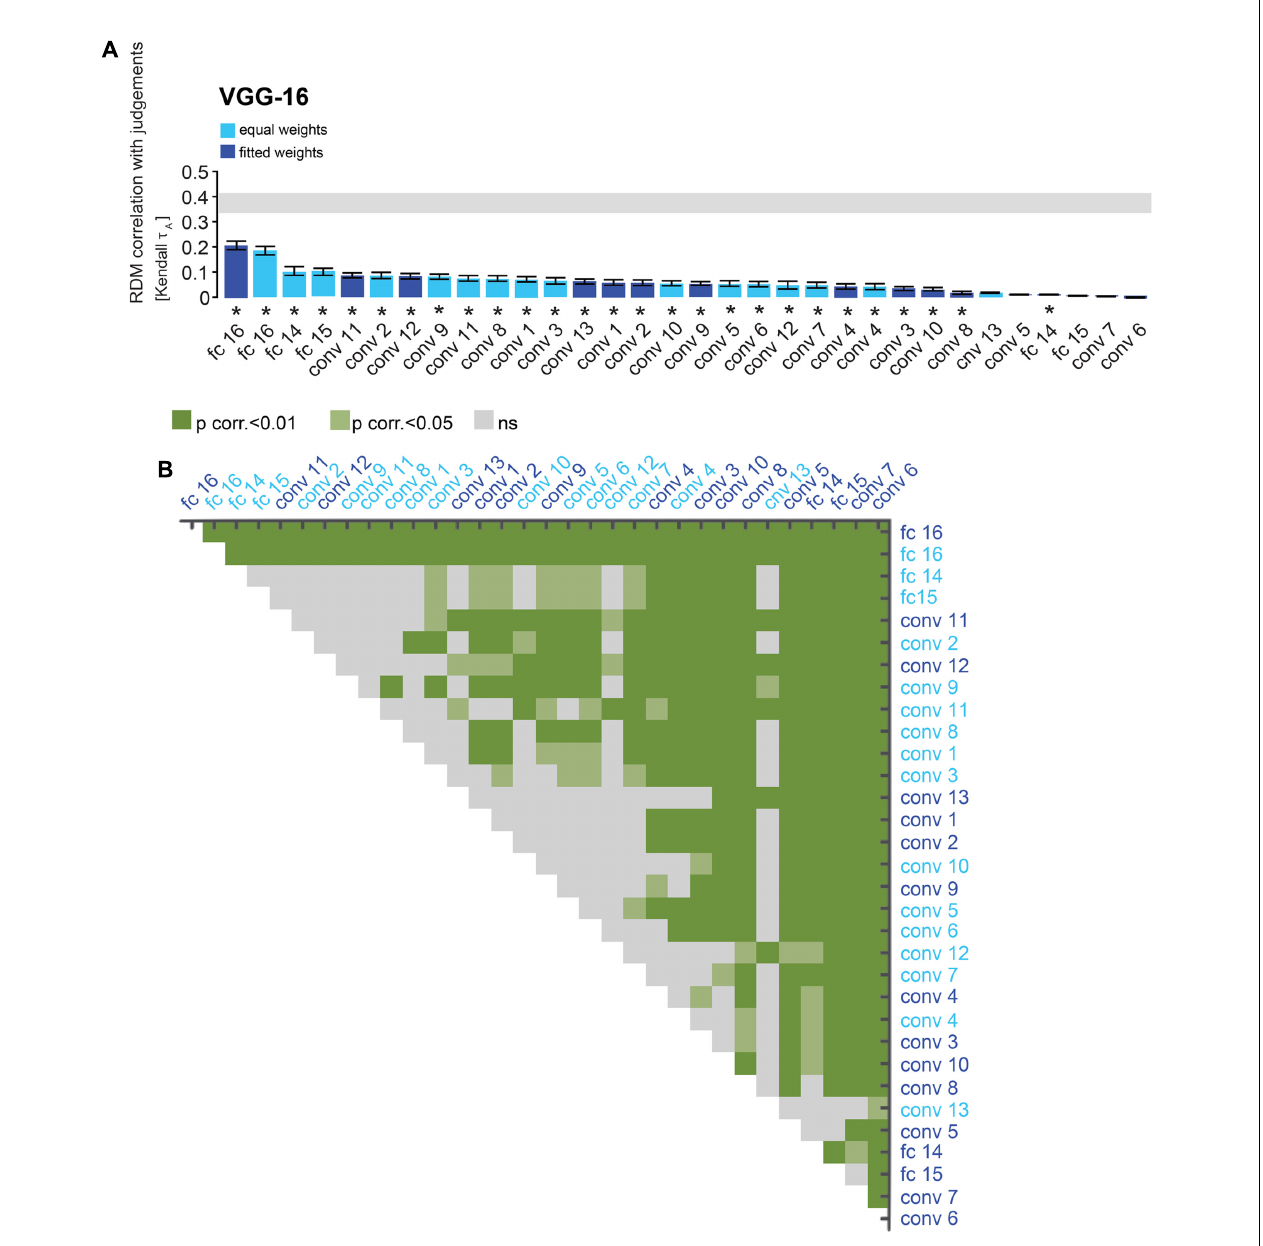
FIGURE 5 | VGG-16 performance at explaining similarity judgments: reweighting improves model performance for layer 16 and late convolutional layers. (A) Bars show the correlation between the similarity-judgment RDMs and each VGG-16 layer RDM, with and without reweighting. Noise ceiling and significant correlations are indicated using the same conventions as in Figure 4 . (B) Pairwise differences between model performance of VGG-16 layer RDMs, with and without reweighting, using the same conventions as in Figure 4 .